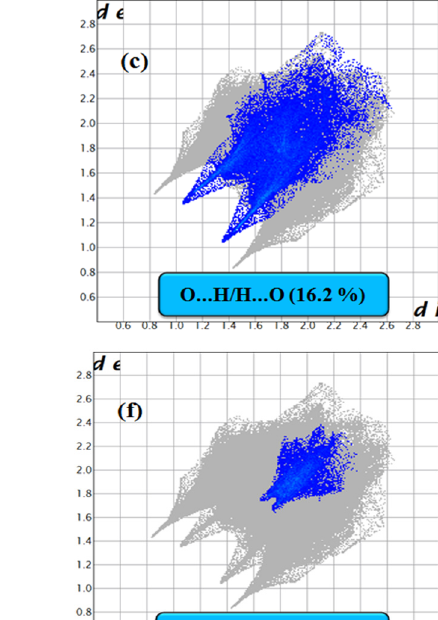
Figure 5. H-bonds present in (C 7 H 6 N 3 O 2 ) 2 [ZnCl 4 ] by d norm .